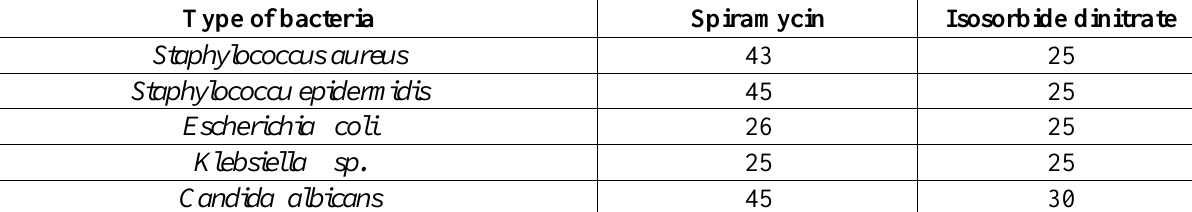
Table 2: Data of antimicrobial test for 200 ppm of